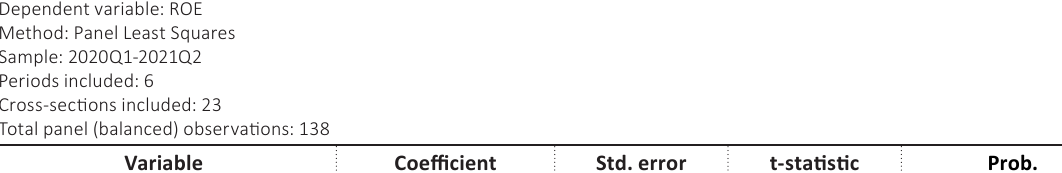
Table 5. OLS model results for